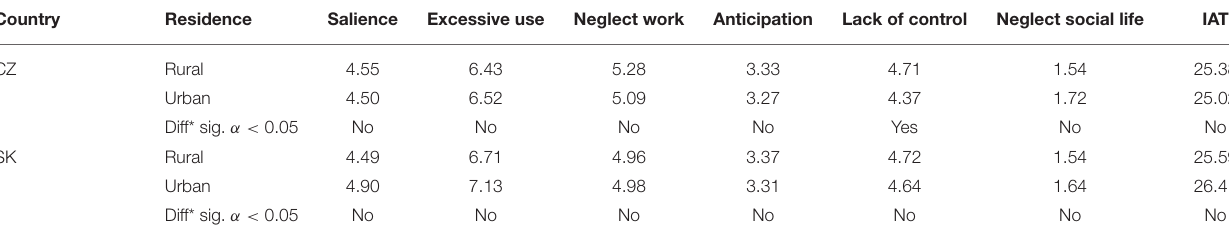
TABLE 5 | Mean values of the IAT and its subscales in the classification by residence. Country